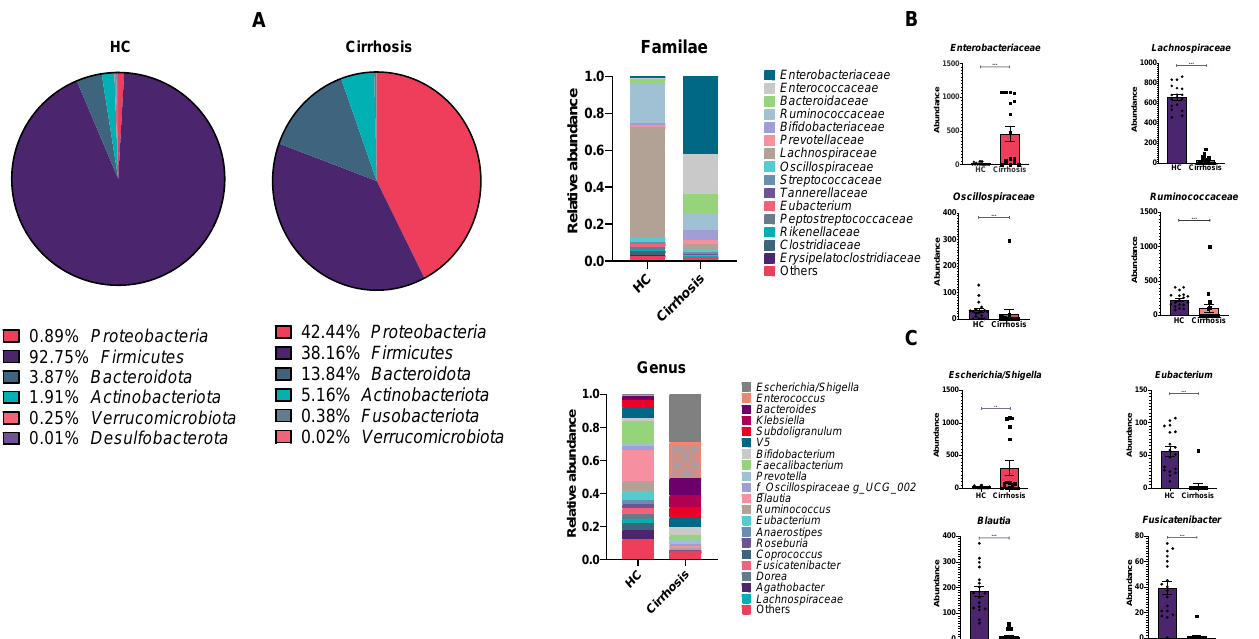
Figure 2. Relative abundance plots of healthy controls group (HC) and patients with cirrhosis group. ( A ) Pie chart representing different phyla in both groups. Phyla are accompanied by relative abundance value (%); ( B ) Stacked bar plot of bacterial familiae in HC group and cirrhosis group ( A ); on the right, increased abundance of Enterobacteriaceae in cirrhosis group are observed, while increased abundance of Lachnospiraceae, Oscillospiraceae and Ruminococcaceae are characteristic of HC group. Below ( C ), stacked bar plot of bacterial genera in HC group and cirrhosis group; in concordance with previous plot, on the right increased abundance of Escherichia / Shigella is characteristic of cirrhosis group, whereas Eubacterium , Blautia and Fusicatenibacter abundance exhibit a significantly increased abundance in HC group. Mann-Whitney U test, *** p < 0.001.